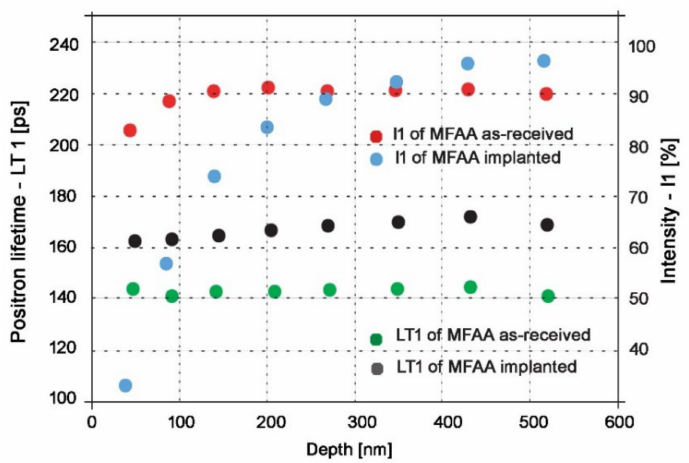
Figure 4. Positron lifetimes (LT 1 ) and intensity of annihilation (I 1 ) in bulk for various energies of incident positrons (penetration depth) for both non-irradiated and proton-irradiated specimens.